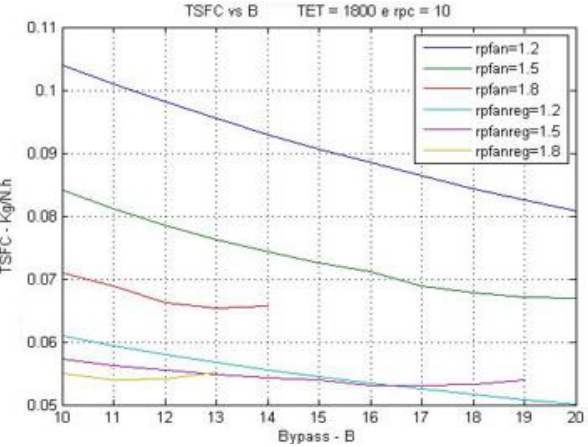
Figure 9: TSFC vs BPR with and without regeneration (TET 1800 K and rpc 10).